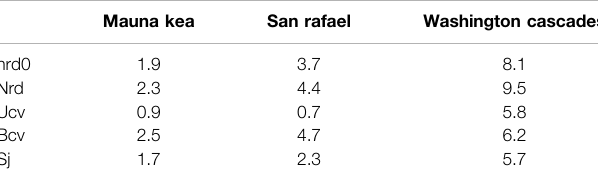
TABLE 1 | Optimal bandwidths (in km) selected with fi ve different methods for three areas of distributed volcanism. Mauna